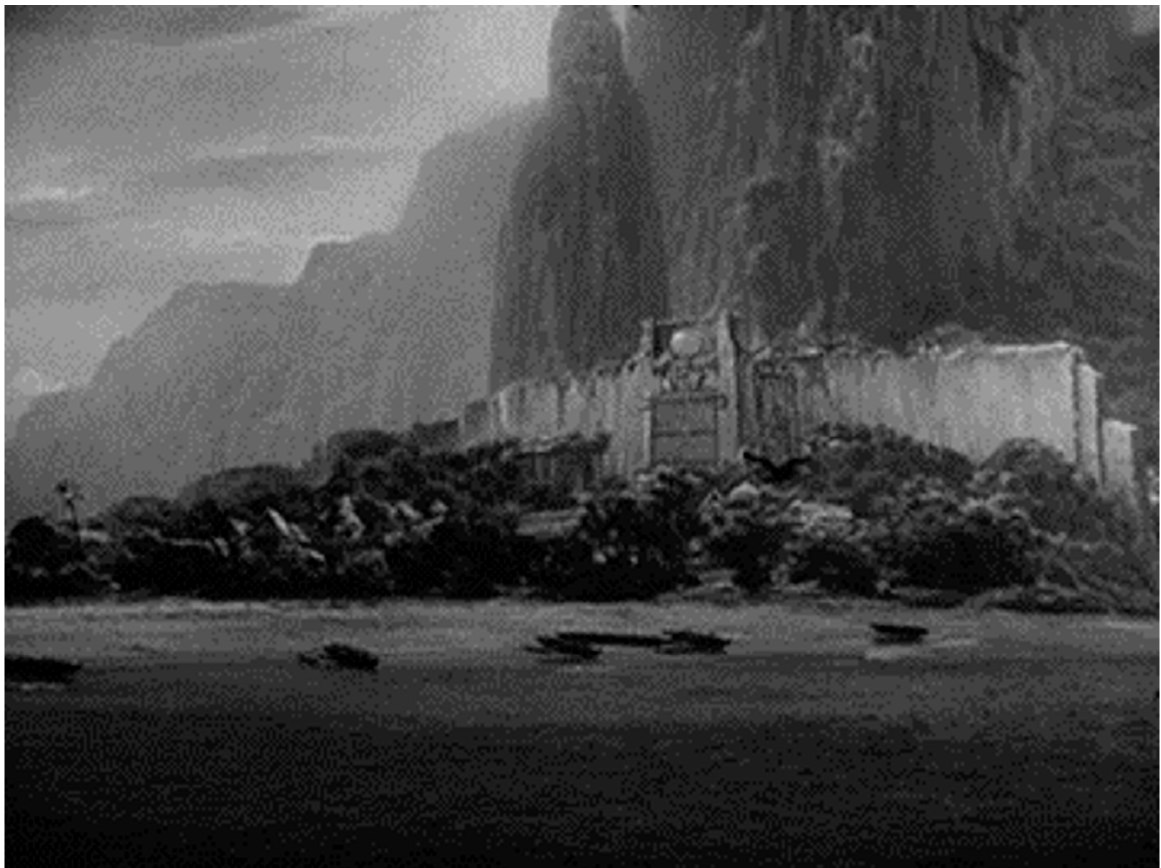
Figure 4. The outer walls of Skull Island: the ocean, the wall, and the mountains (1933). https://lh3.googleusercontent.com/proxy/3yTNlC8SJYRy_IGNeNFxvhcZXzABt1NCus3CG9-yISnsjidzxA4hAFQRCA4G2rrXGwhjINNfbWxZ_4juVvM-ibuyaFpuIDSkTcTcTBOK0zuFpuxSkTcTBOK0 (accessed on 1 January 2021).